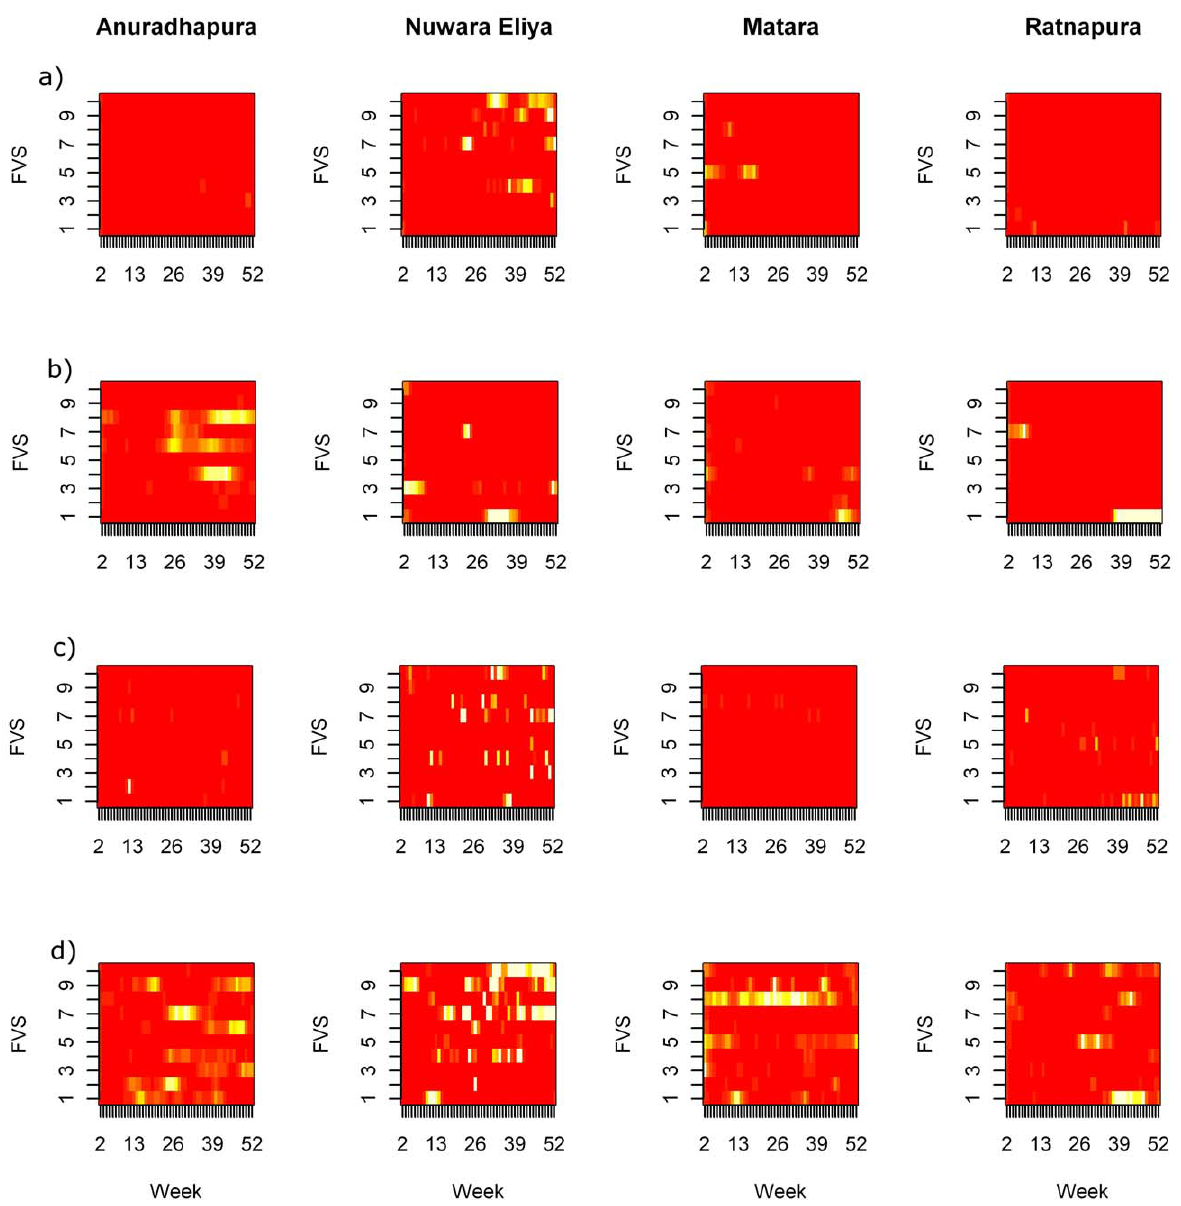
Figure 7. Posterior mean of the state variable. The model-adjusted posterior mean state for each field veterinarian surgeon by week, in each of the study districts for commonly reported cattle diagnoses. Red indicates state one and white indicates state two, and yellow intermediate values for a) Milk Fever, b) Ephemeral Fever, c) Babesiosis, and d) Mastits.